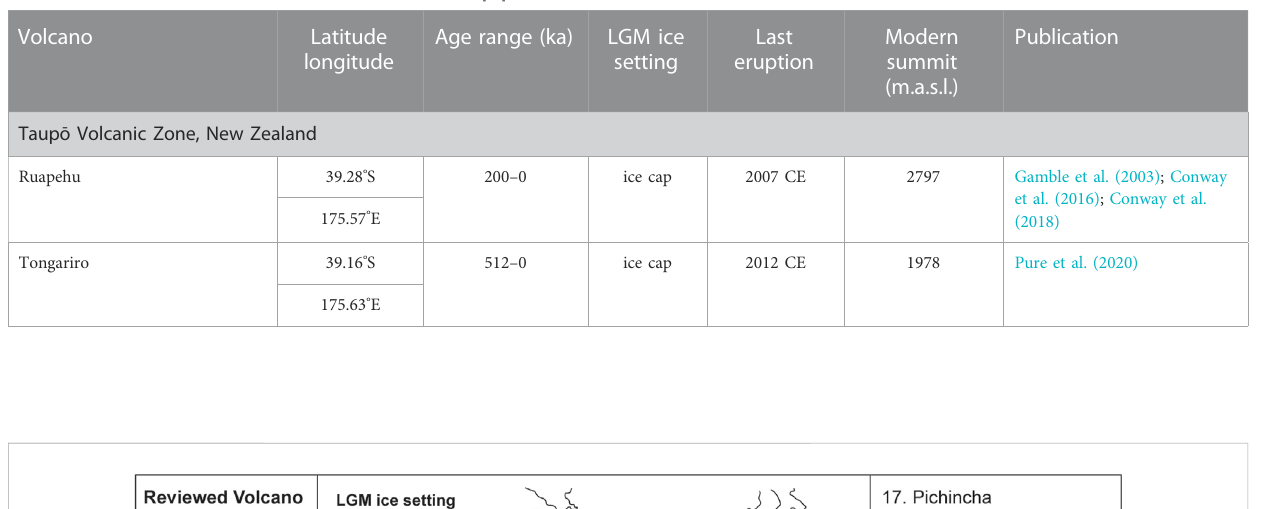
TABLE 1 ( Continued ) Glaciated volcanoes considered in this